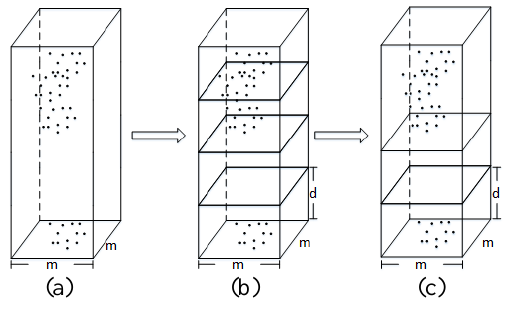
Figure 5. Elevation stratification-merge diagram. (a) Raw Point Cloud data; (b) Stratification; (c) Merge of the non-empty cells.